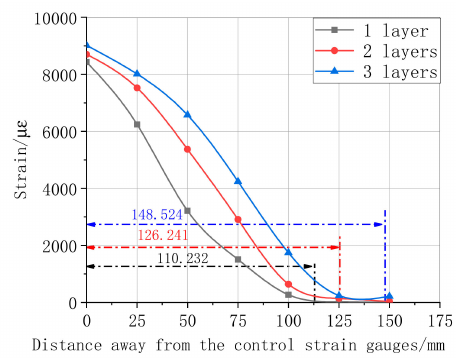
Figure 12. Ultimate strain of di ff erent CFRP layers of bonding length 350